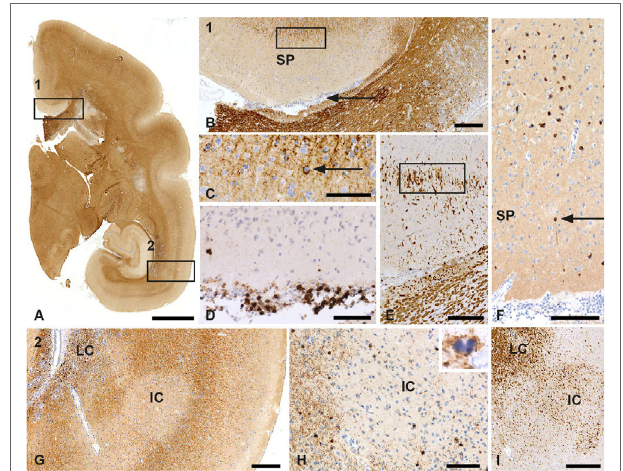
FiGURe 3 | Patterns of gray matter (GM) demyelination in a monkey sensitized against MOG34–56 in incomplete Freund’s adjuvant (IFA). (A) Patterns of demyelination (PLP) staining of the right hemisphere of a marmoset with IFA myelin oligodendrocyte glycoprotein experimental autoimmune encephalomyelitis. Rectangle 1 encloses a subpial lesion [enlargement in (B) ] while the area in rectangle 2 indicates a leukocortical (LC) and intracortical (IC) lesion; an enlargement is shown in (G) . (B) PLP staining shows the cortex above the corpus callosum. The area indicated by secondary progressive (SP) is a demyelinated GM subpial area. The rectangle here shows the border of the subpial lesion that is enlarged in (C) . The arrowhead in this figure points at a meningeal infiltrate. (C) In this enlargement, the arrowhead points at a macrophage (Mf) with PLP degeneration products. (D) The meningeal infiltrate adjacent to the subpial lesion (B) contains a large number of CD3 + T cells. (e) Staining for MRP14 shows that cells at the border of the subpial lesion have a microglia morphology. (F) Staining for TPPP shows the absence of oligodendrocytes (ODC) in the subpial lesion. The arrowhead points at a single surviving oligodendrocyte. (G) PLP staining shows the LC and IC lesion from the areas indexed by the rectangle in (A) . (H) Staining for CNPase shows the absence of ODC in the center of the IC lesion. The inset shows a PLP + apoptotic oligodendrocyte at the border of the lesion. (i) Staining for MRP14 shows the presence of Mfs/microglia in the LC and IC lesion. Size bars: (A) 2 mm; (B) 250 µm; (C–F) 100 µm; (G) 250 µm; (H,i) 100 µm.